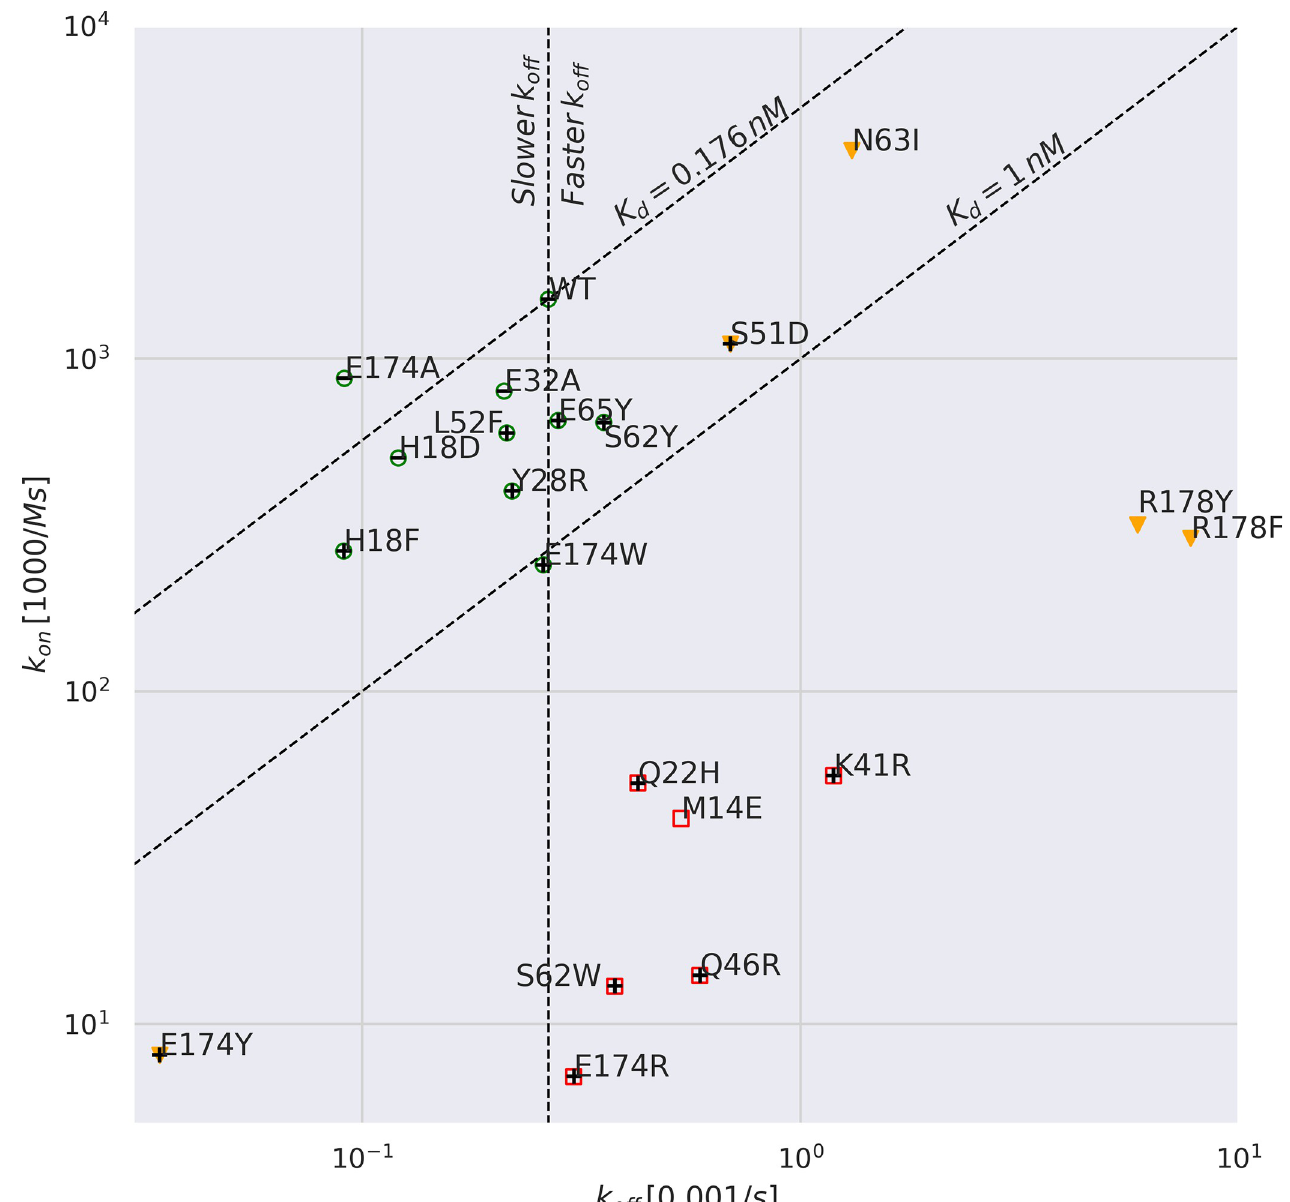
Fig 4. k on vs k off . Dashed diagonals are iso-affinity contours (at WT and 1nM affinities). Vertical dashed line separates koff slower on left (blue circles) from faster than WT on right (red squares). M14W is off the scale (very fast koff, low affinity). We identified a cluster of higher- affinity mutants (green circles) of which many (including E174A) have slower koff than WT, but also slower kon. The slowest koff belong to substitutions at zinc binding triad positions H18 and E174 (we did not mutate the third position, H21). We also identified a group with moderately faster koff but much slower kon (red squares). Mutants outside these two groups are marked with yellow triangles. “+” markers superimposed on the above indicate an increase in molecular mass, from WT to mutant, while “-” markers indicate a decrease in molecular mass. Substitutions with small mass changes have neither of these markers. Note that the three mass-decreasing mutants (E174A, H18D, E32A) are among the four highest-affinity mutants. N63I, the fourth mutant, also has a (slight) decrease in